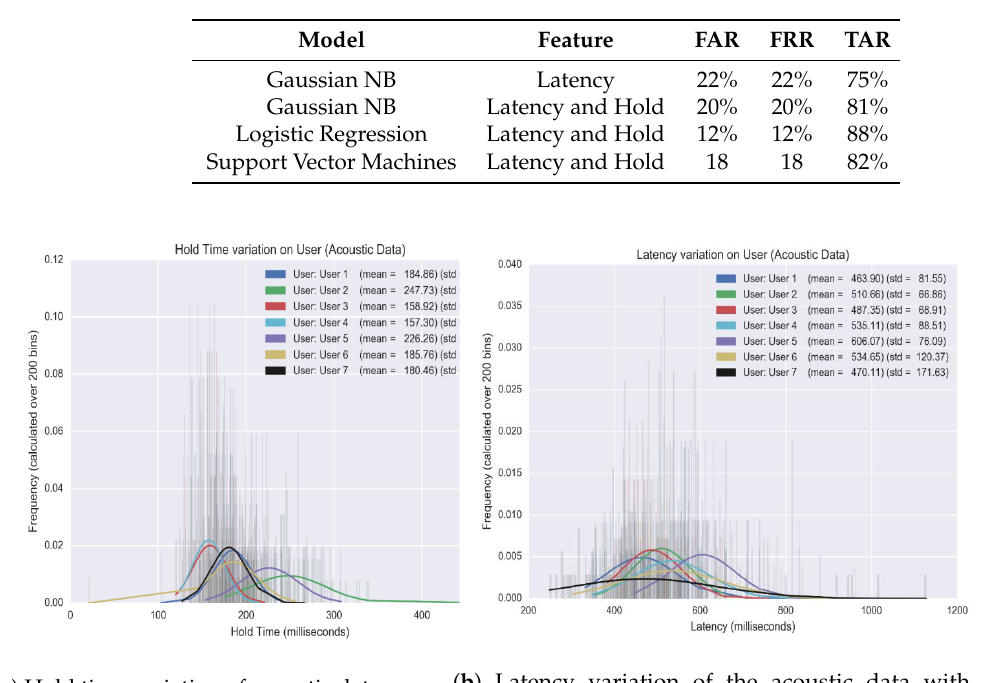
Table 3. Overall results (Acoustic Biometric Verification).